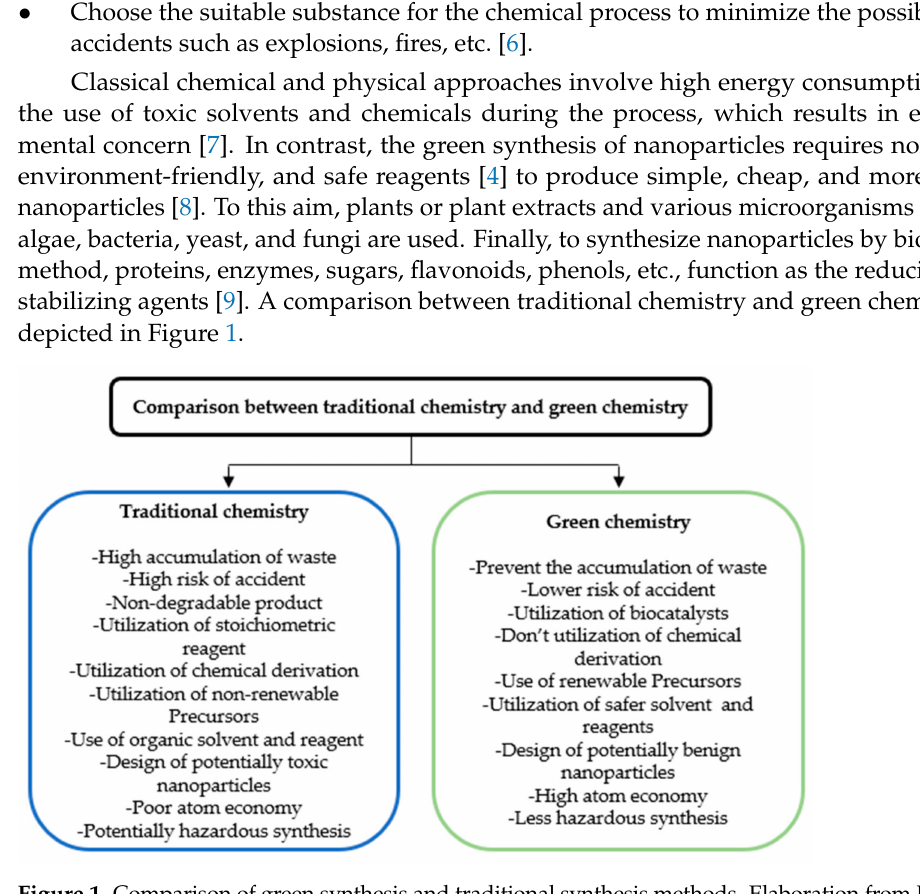
Figure 1. Comparison of green synthesis and traditional synthesis methods. Elaboration from Ref.